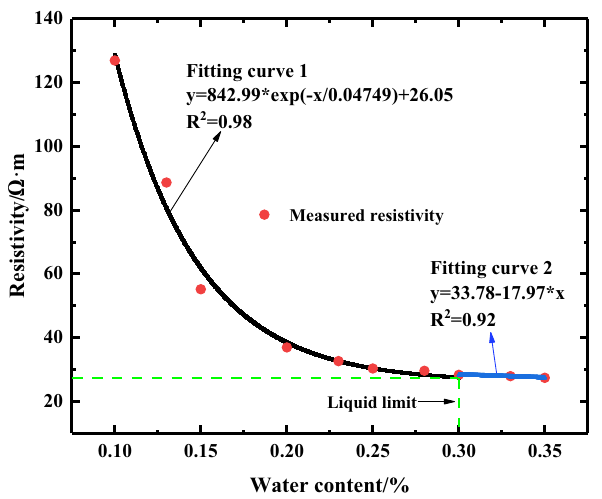
Figure 8. The characteristic curve of the relationship between water content and resistivity of